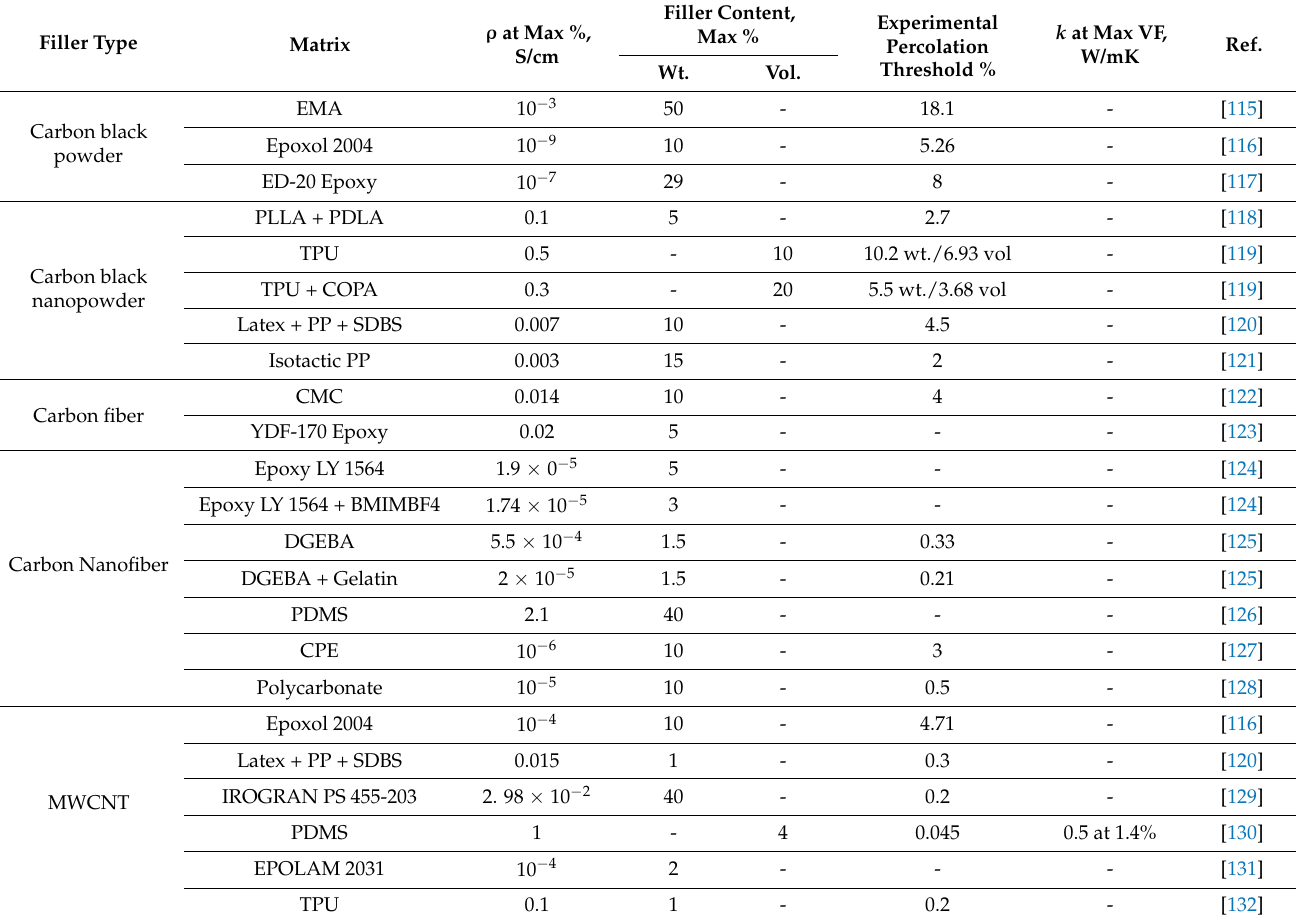
Table 2. Properties of polymers with electrically conductive